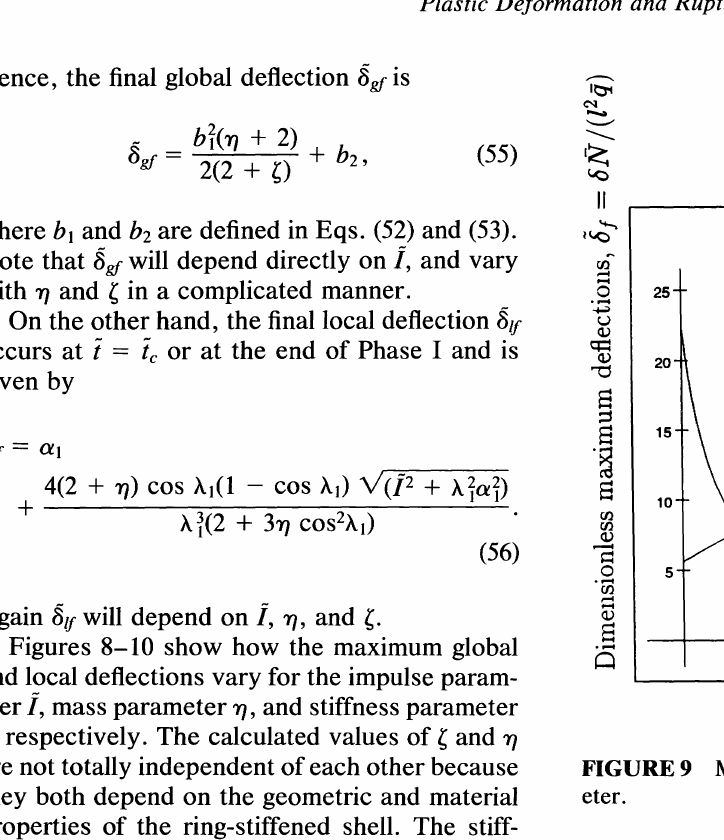
FIGURE 9 Maximum deflection versus mass param eter.